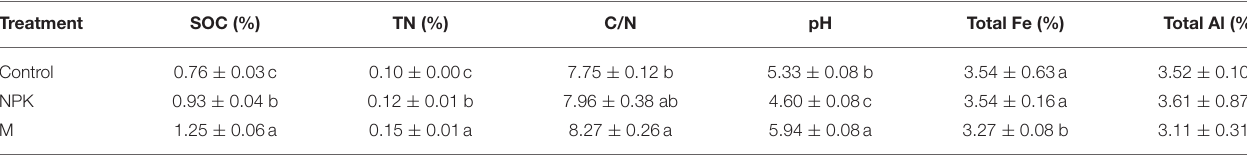
TABLE 1 | Characteristics of soils from the different fertilization treatments at the Jiangxi Institute of Red Soils, Jinxian, China a . Treatment